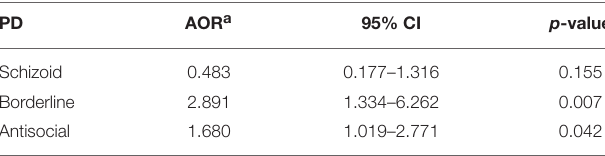
TABLE 4 | Multivariate logistic regression models to estimate the association between each personality disorder (PD) and methamphetamine (MA)